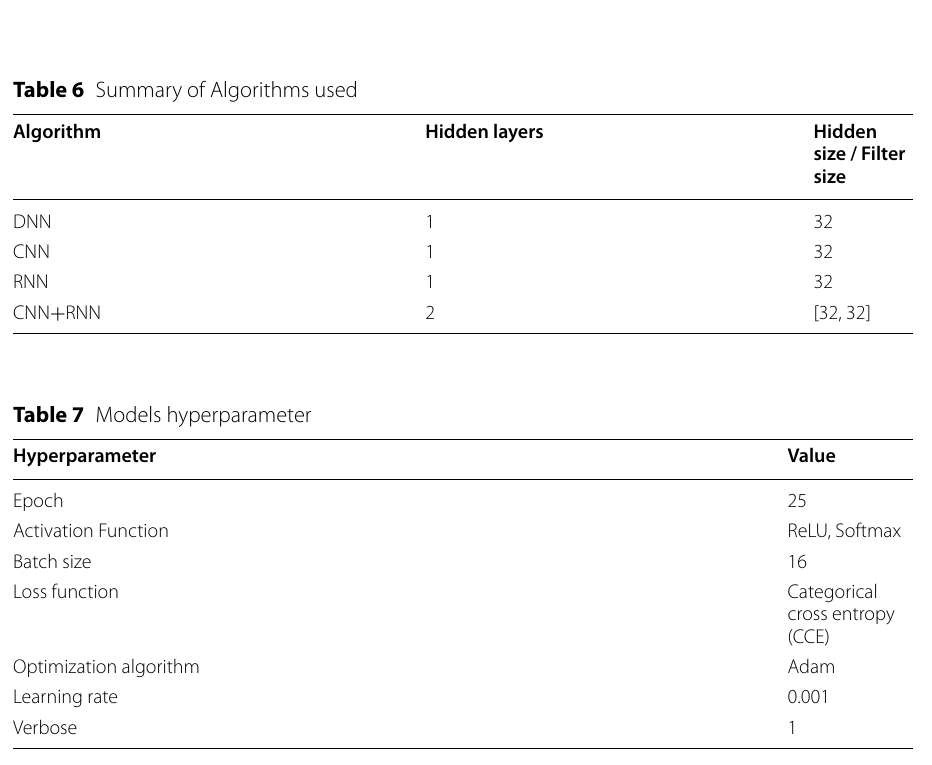
Fig. 10 Proposed CNN